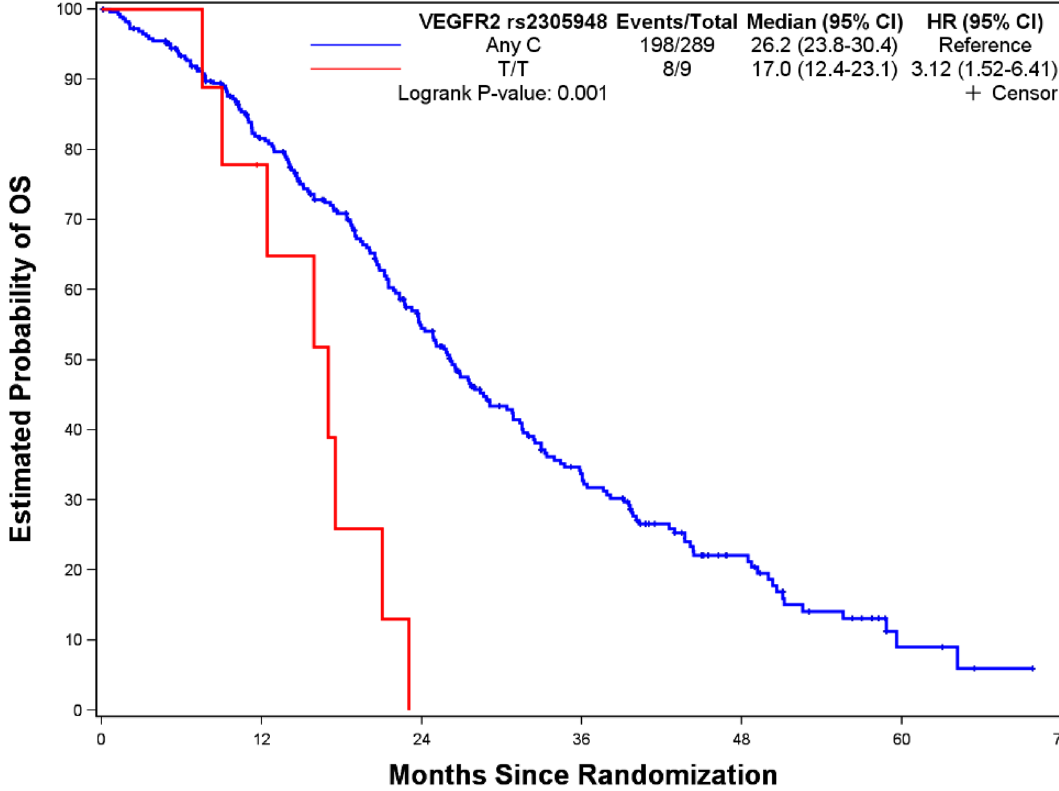
Figure 7. Kaplan–Meier curve and log-rank test for angiogenesis pathway SNP, VEGFR2, predictive of OS in KRAS wild-type mCRC patients. Patients with VEGFR2 rs2305948 Any C carriers have significantly longer OS (26.2 vs. 17.0 mo; p = 0.001) compared to T/T